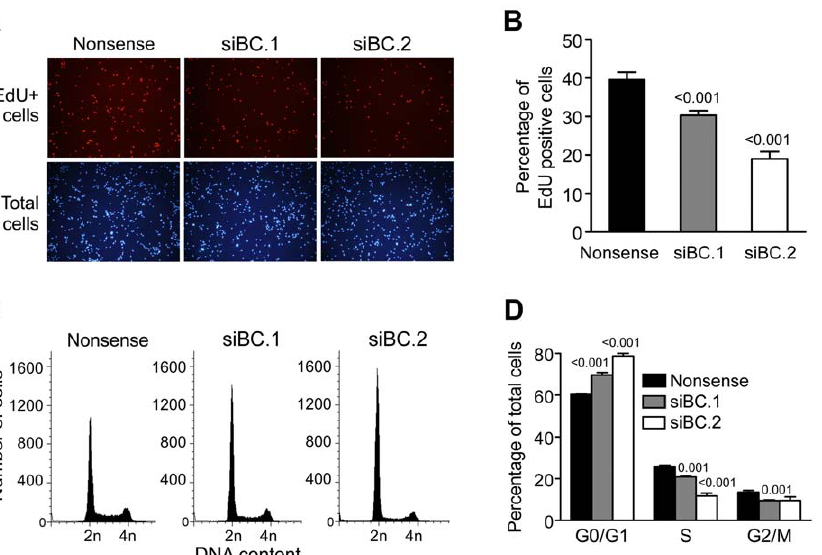
Figure 7. Knock-down of BC induced G1/S phase arrest and thus inhibited cell proliferation in NIH/3T3 cells. ( A ) Representative fluorescent images of EdU incorporation assay. Blue nuclei represent total cells visualized by UV excitation, while red nuclei represent EdU-positive cells visualized by green light excitation. ( B ) Quantitative analysis of EdU-positive cells (shown in A). A total of . 4000 cells were counted for each group. Data were mean 6 s.d. of three independent experiments. ( C ) Flow cytometric analysis of cell cycle in NIH/3T3 cells transfected with nonsense or BC siRNAs at 48 h after siRNA transfection. 2n=cells in G0/G1 phase, and 4n=cells in G2/M phase. ( D ) Quantitative analysis of cell cycle phase distribution (shown in C). Data were mean 6 s.d. of at least three independent experiments performed in triplicate. Values shown on top of bars are P values vs nonsense.